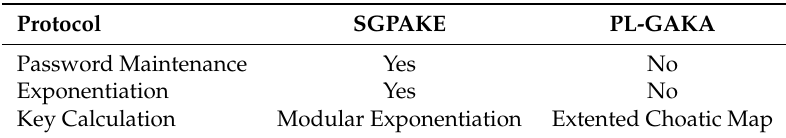
Table 3. The efficiency comparison between SGPAKE and